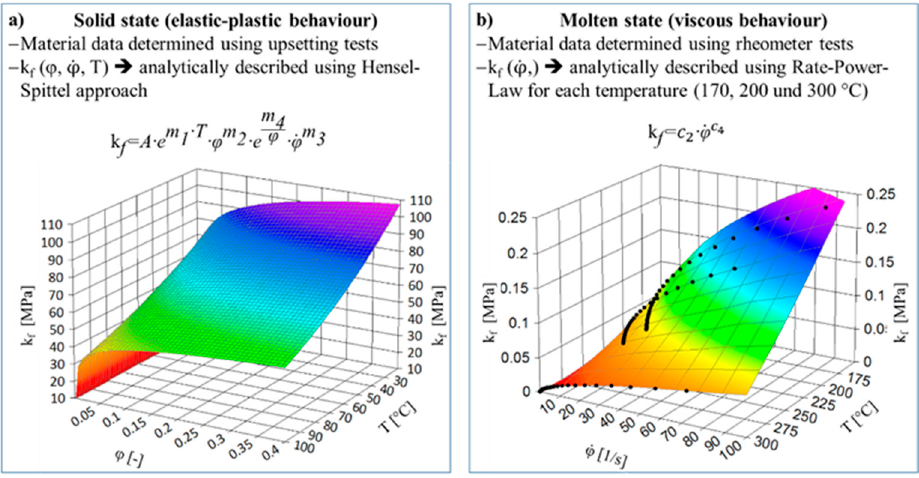
Figure 10. Characterization of the material properties for the solid ( a ) and molten state ( b ).